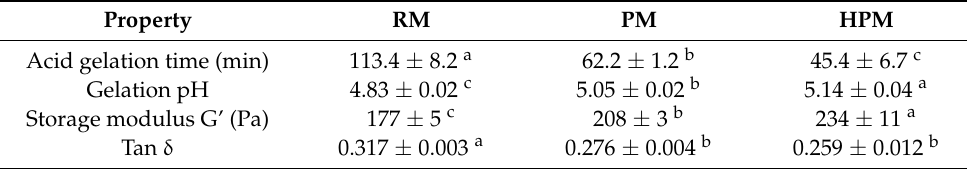
Table 5. Acid gelation properties of differently processed deer milks